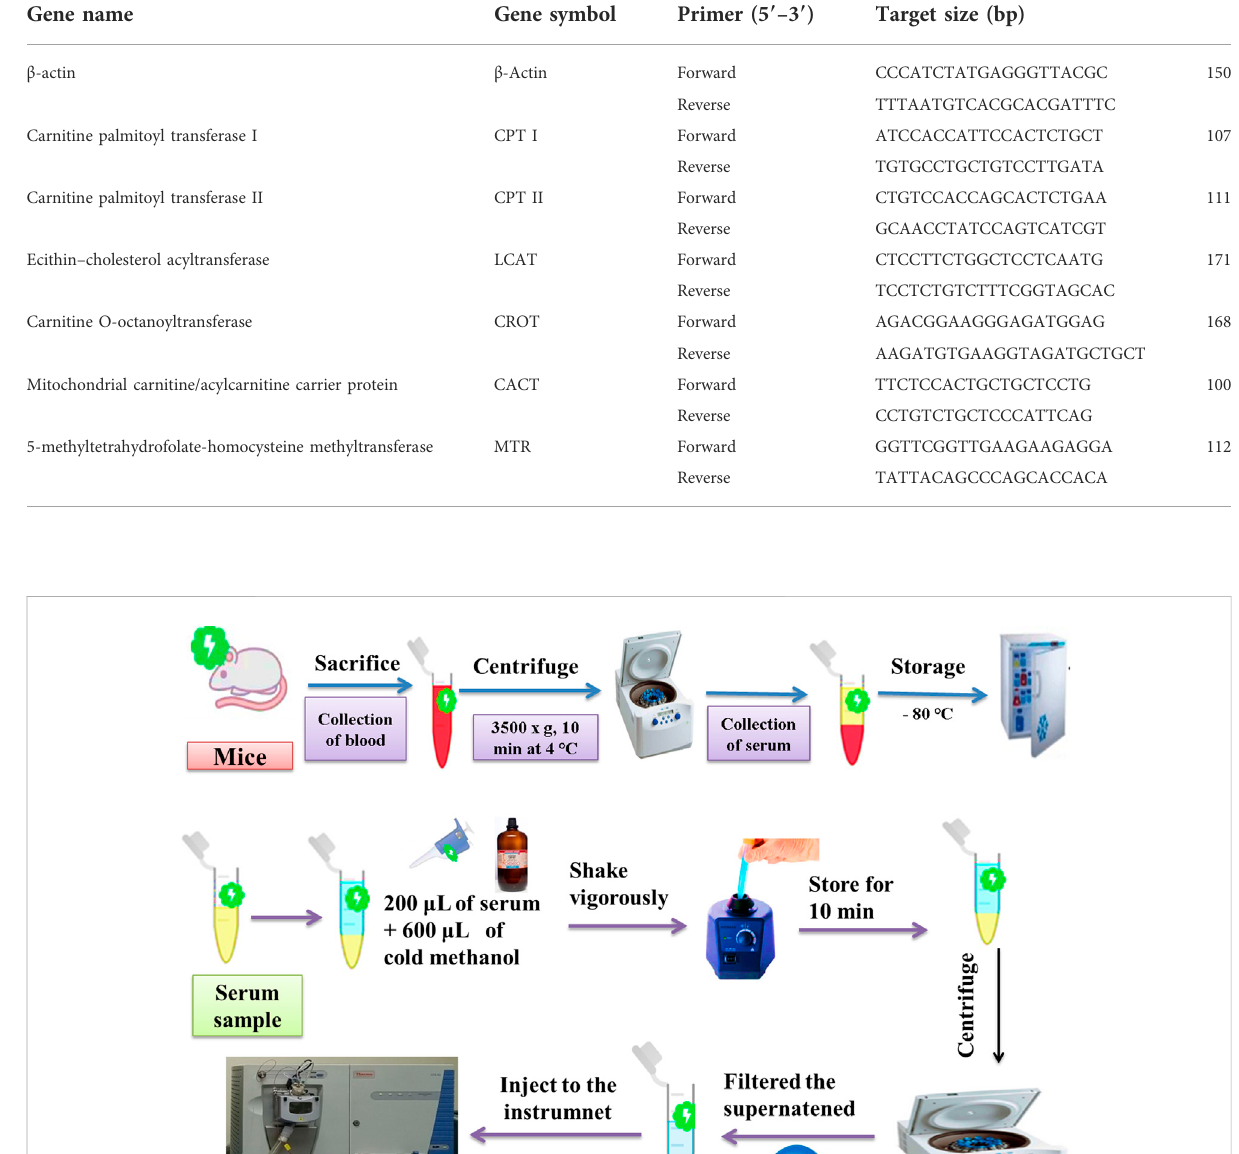
TABLE 1 List of primers employed in qRT-PCR analysis of targeted genes.